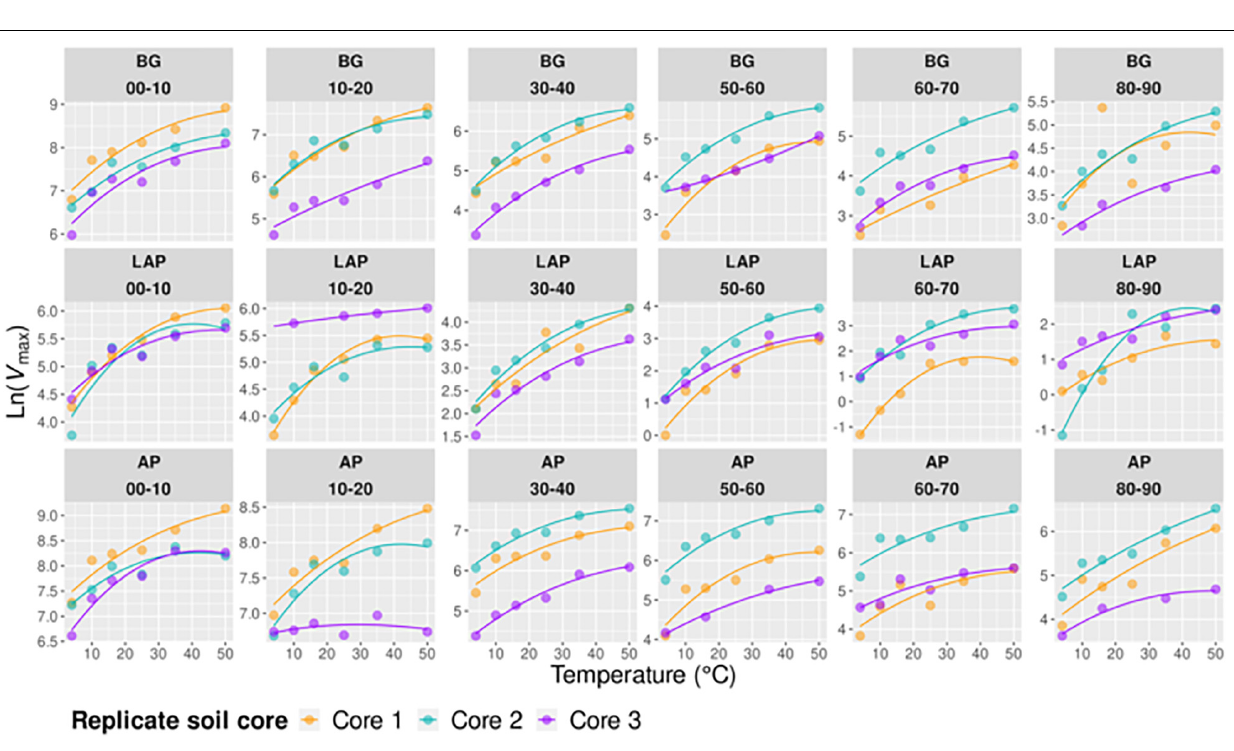
Frontiers in Microbiology |